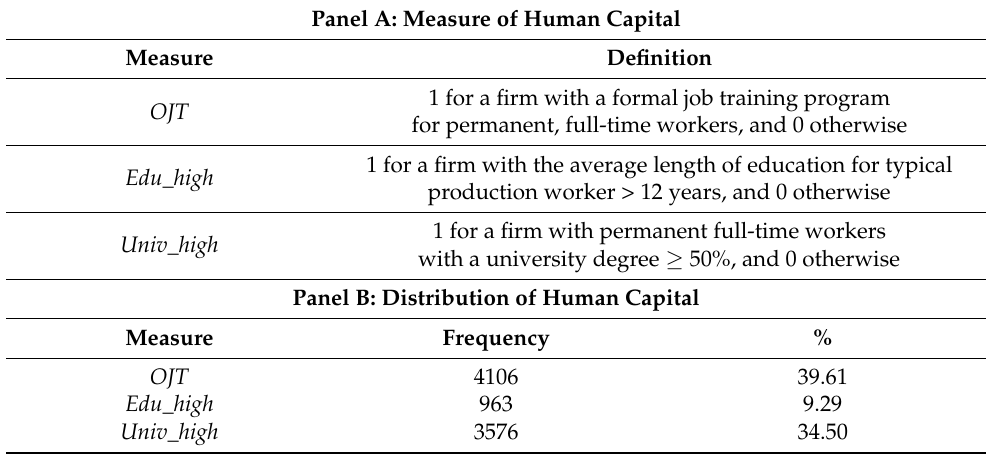
Table 3. Test variable of main